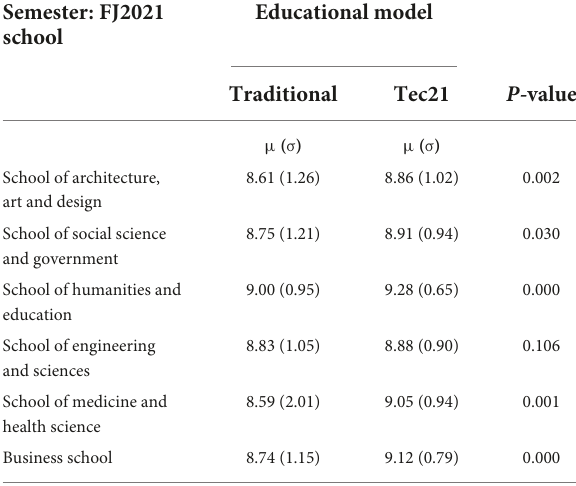
TABLE 4 Statistical significance ( p -value) of two-tailed t -test comparison between educational models for the FJ2021